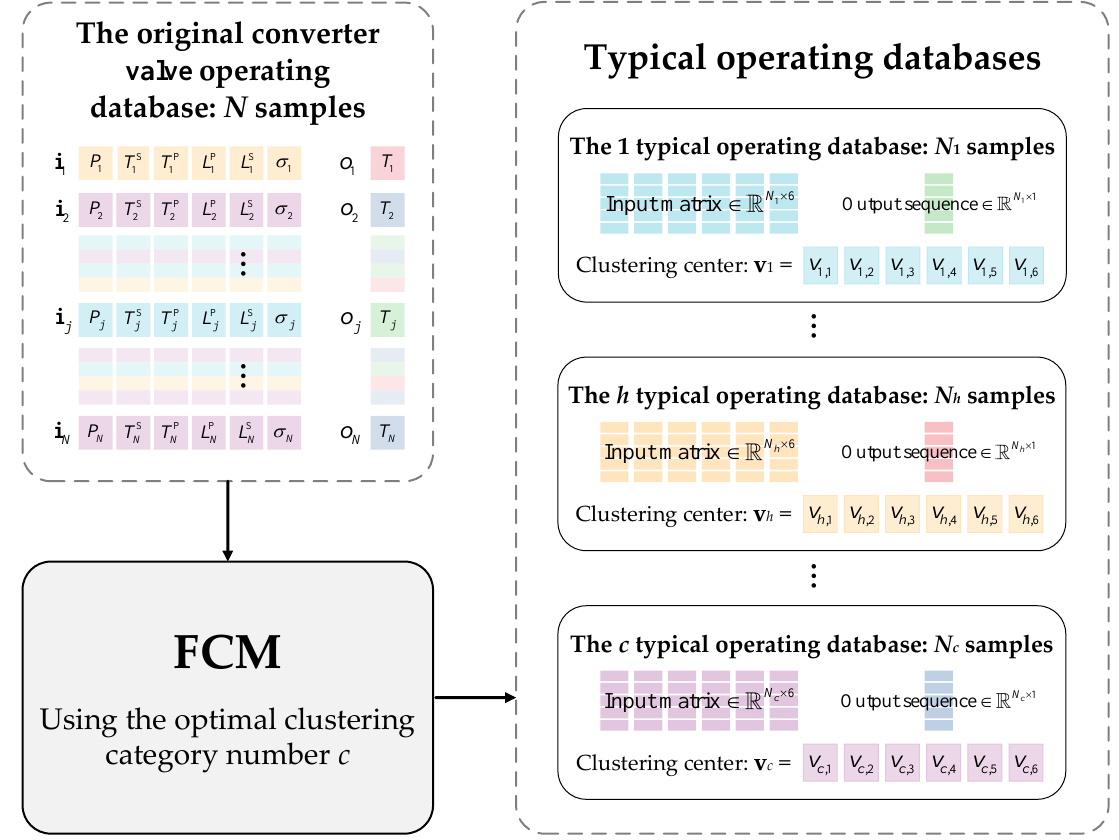
Figure 7. Diagram of the construction of a typical database for a converter valve.